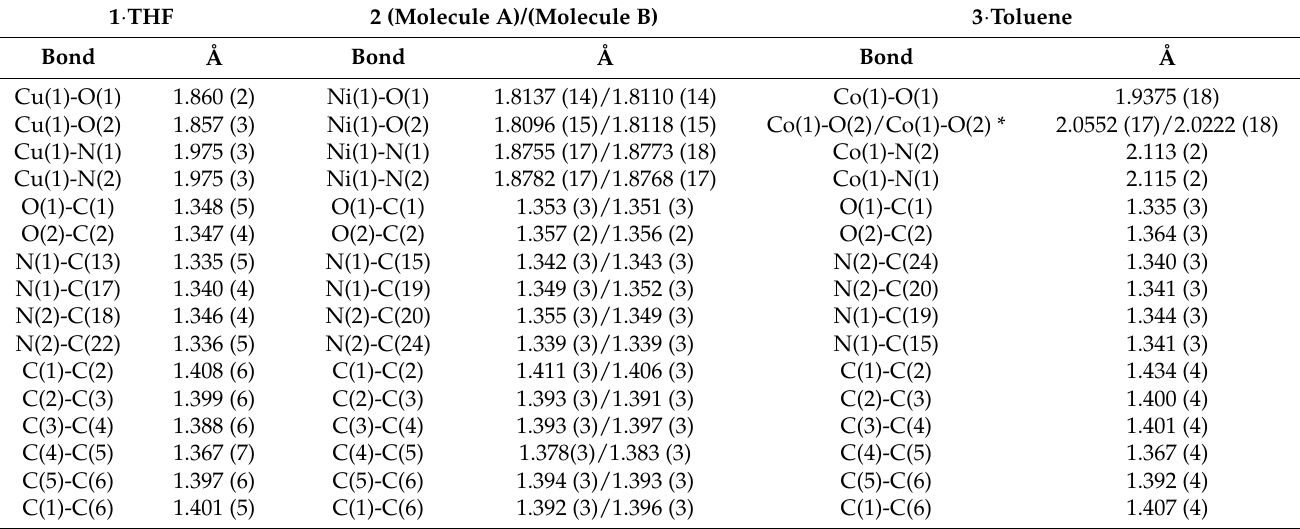
Table 2. Selected bond lengths for complexes 1 – 3 .